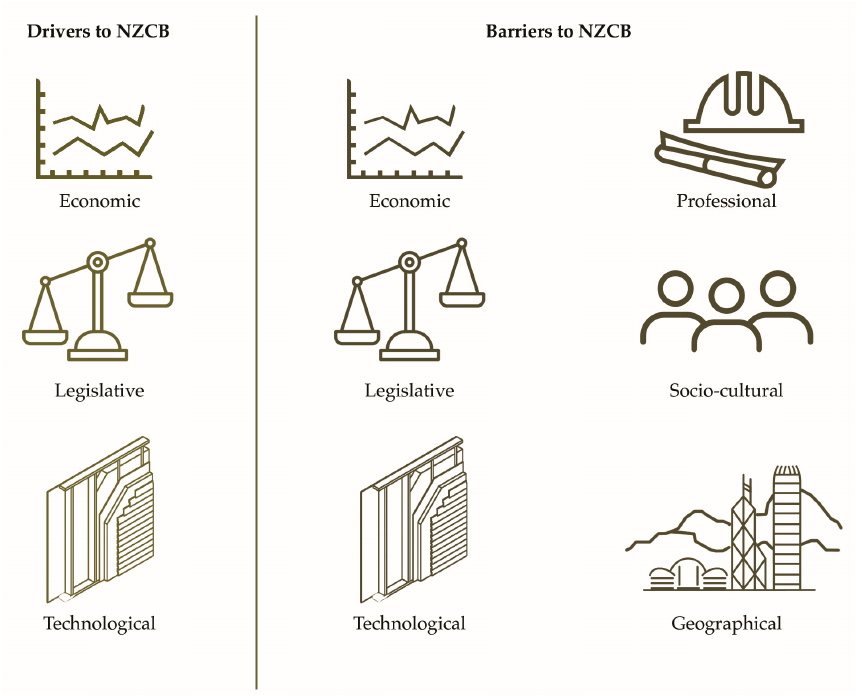
Figure 2. Drivers and barriers for net zero carbon buildings: it is possible to sum them up into six categories .